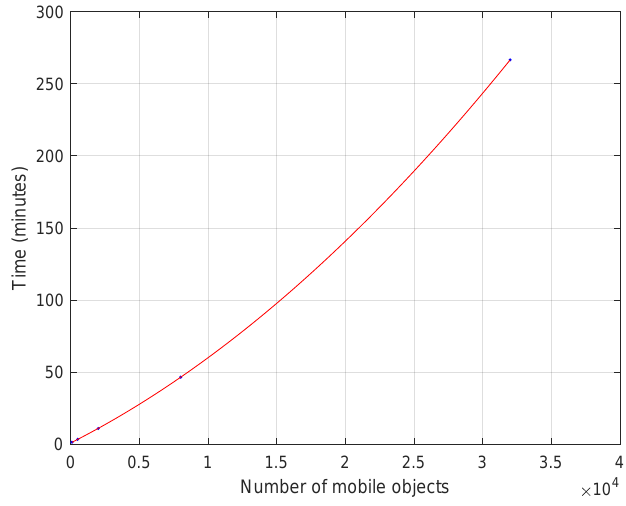
Figure 7. Time Cost for Mobile Objects N = { 500,2000,8000,32.000 } without Indexing for k = 8.